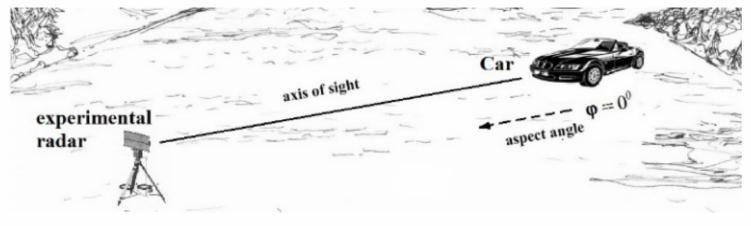
Figure 4. Scheme of the